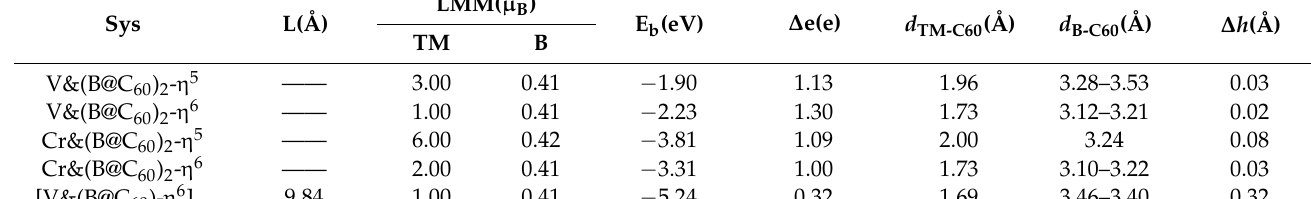
Table 1. Optimized lattice constant (L, Å), local magnetic moment of TM atom and B atom (LMM, ∆ e, e) transferred from TM atom to B@C µ 60 molecule, B ), binding energy (E b , eV), the Bader charge ( distance of TM atom to the mass center of faced C n rings (d TM-C60 ), distance of B atom to the mass center of the nearest η 5 - or η 6 -carbon ring in C 60 (d B-C60 , Å), deviations of the encapsulated B atom to the mass center of C 60 molecule ( ∆ h , Å).